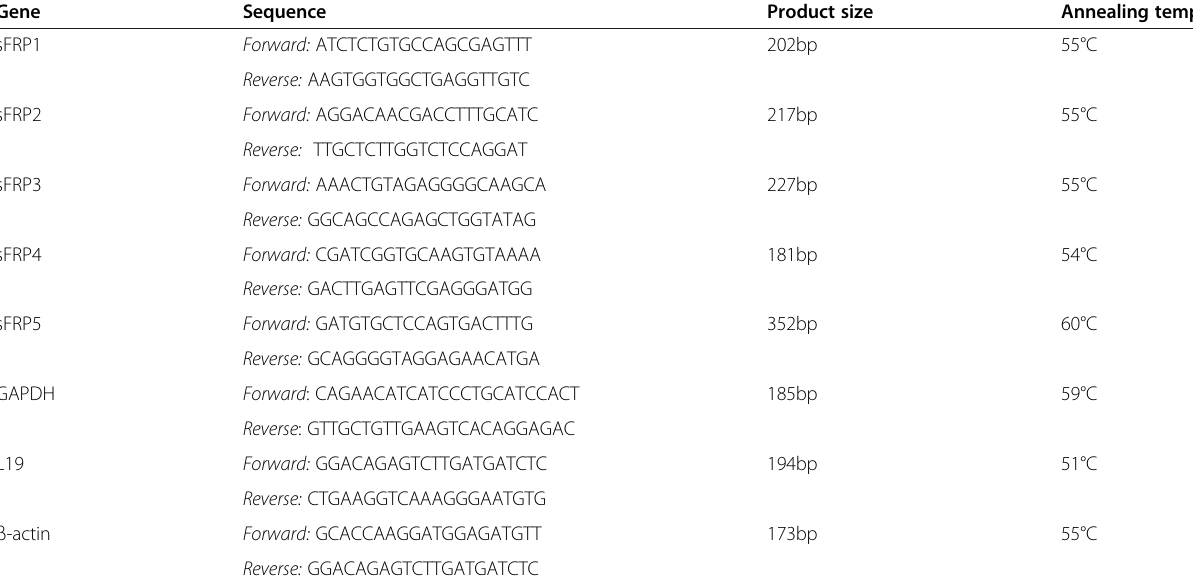
Table 1 Primer sequences, product size and annealing temperature